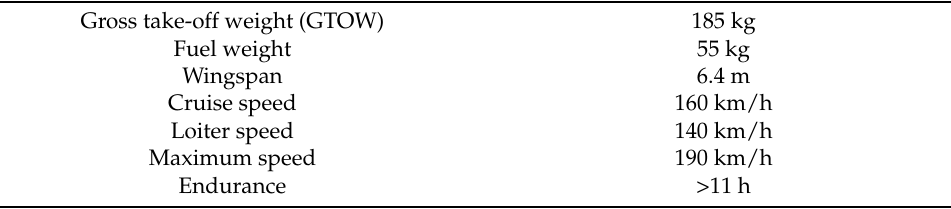
Table 1. Specification of the HCUAV